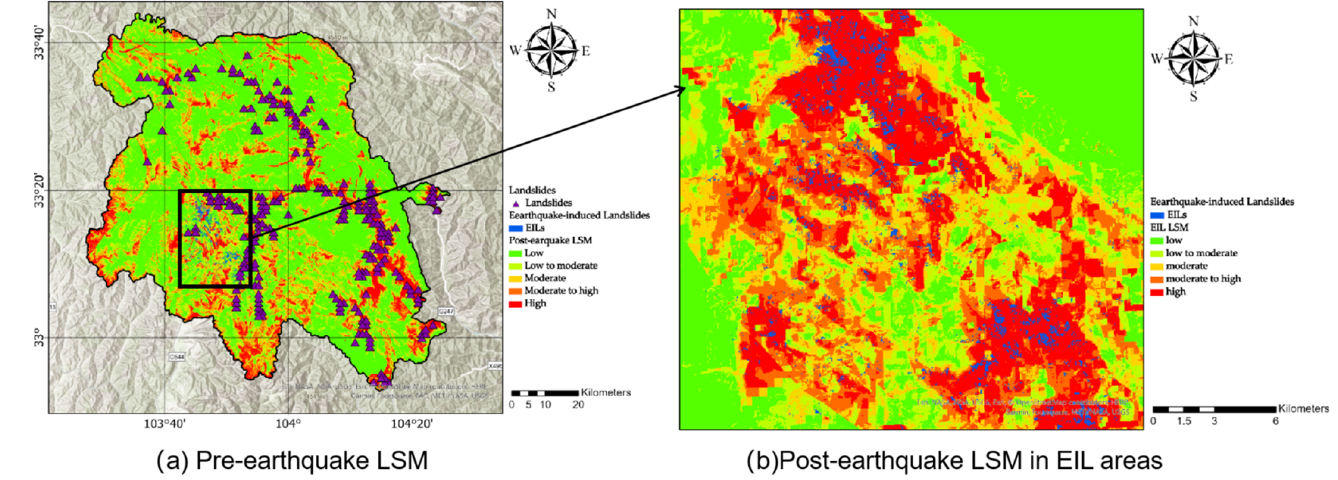
Figure 11. Pre-earthquake and pro-earthquake landslide susceptibility map in EIL areas.